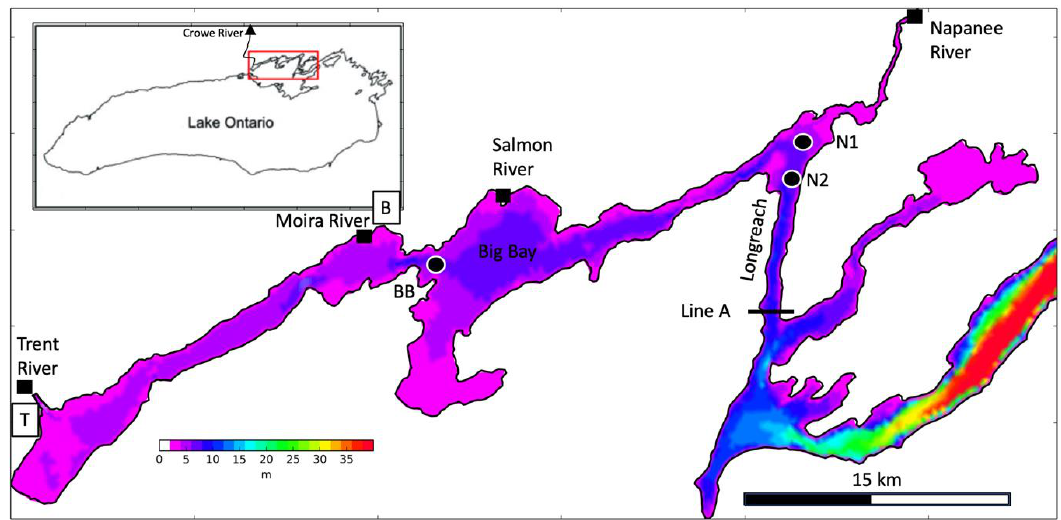
Figure 1. Bathymetry of the Bay of Quinte located on the northern side of Lake Ontario (see inset; location of the Crowe River is also given in the inset ( ▲ )). Locations of the Trent, Moira, Salmon and Napanee Rivers are marked ( ◾️ ). Drifter releases in 2017 at 2 sites: BB and N2; Environment and Climate Change Canada (ECCC) 2016 temperature site N1 (sites marked with ⚫️ ). Location of Trenton (T) and Belleville (B) are marked. Table 1. Percent of total catchment area and average river discharge for Bay of Quinte tributaries.